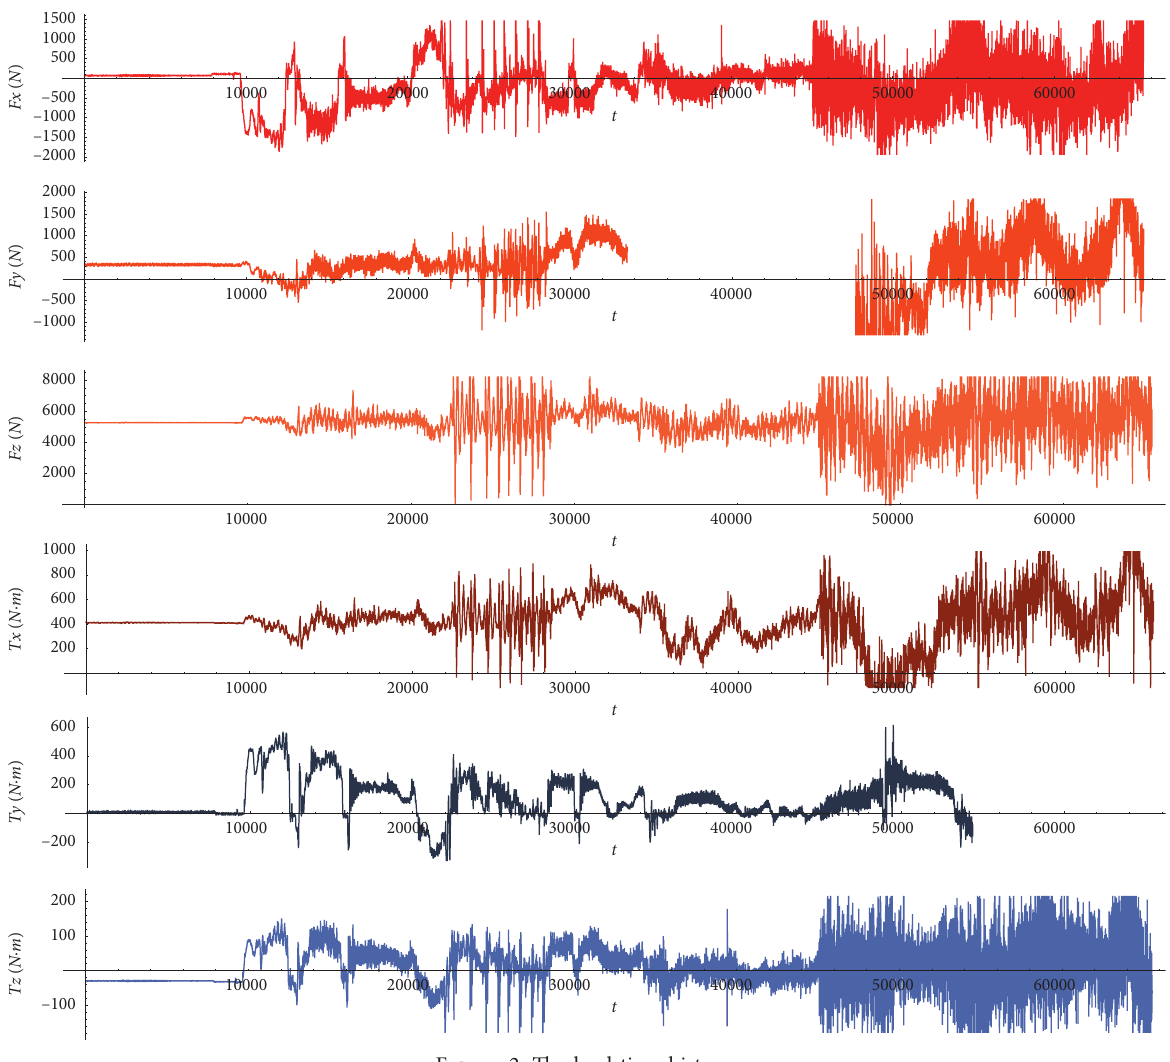
Figure 2: The load-time